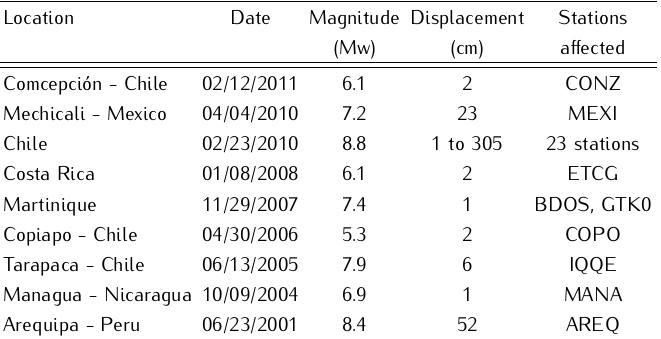
Table 1. Displacement of stations of the SIRGAS-CON network after the earthquakes that happened between 2000 and 2011 (Sànches and Seitz, 2011,